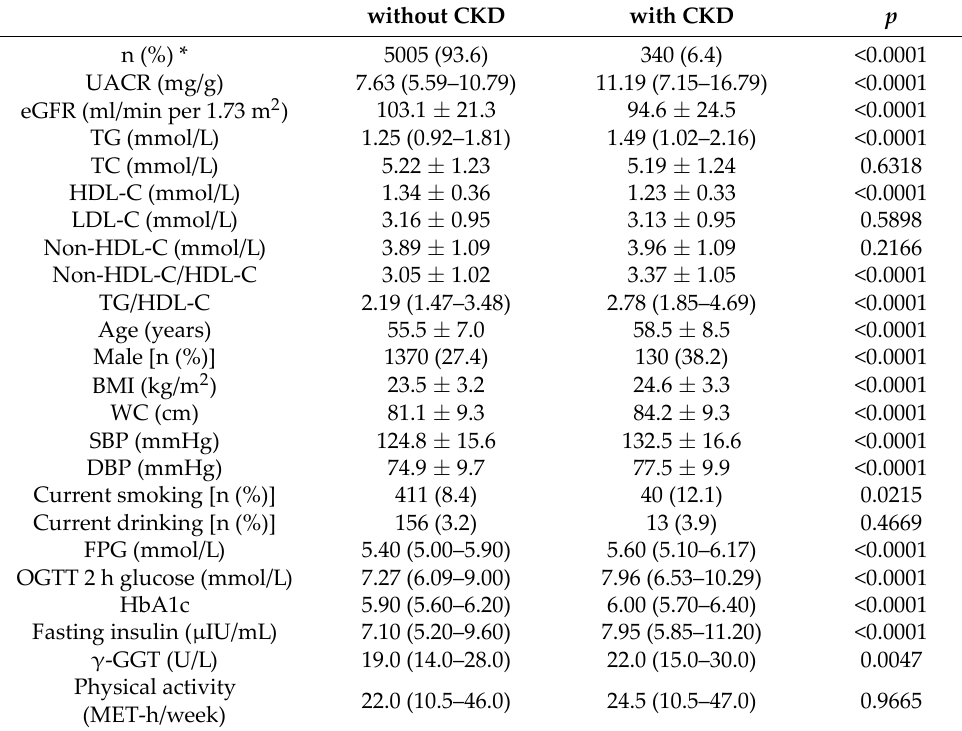
Table 1. Baseline characteristics of study population by CKD status at follow